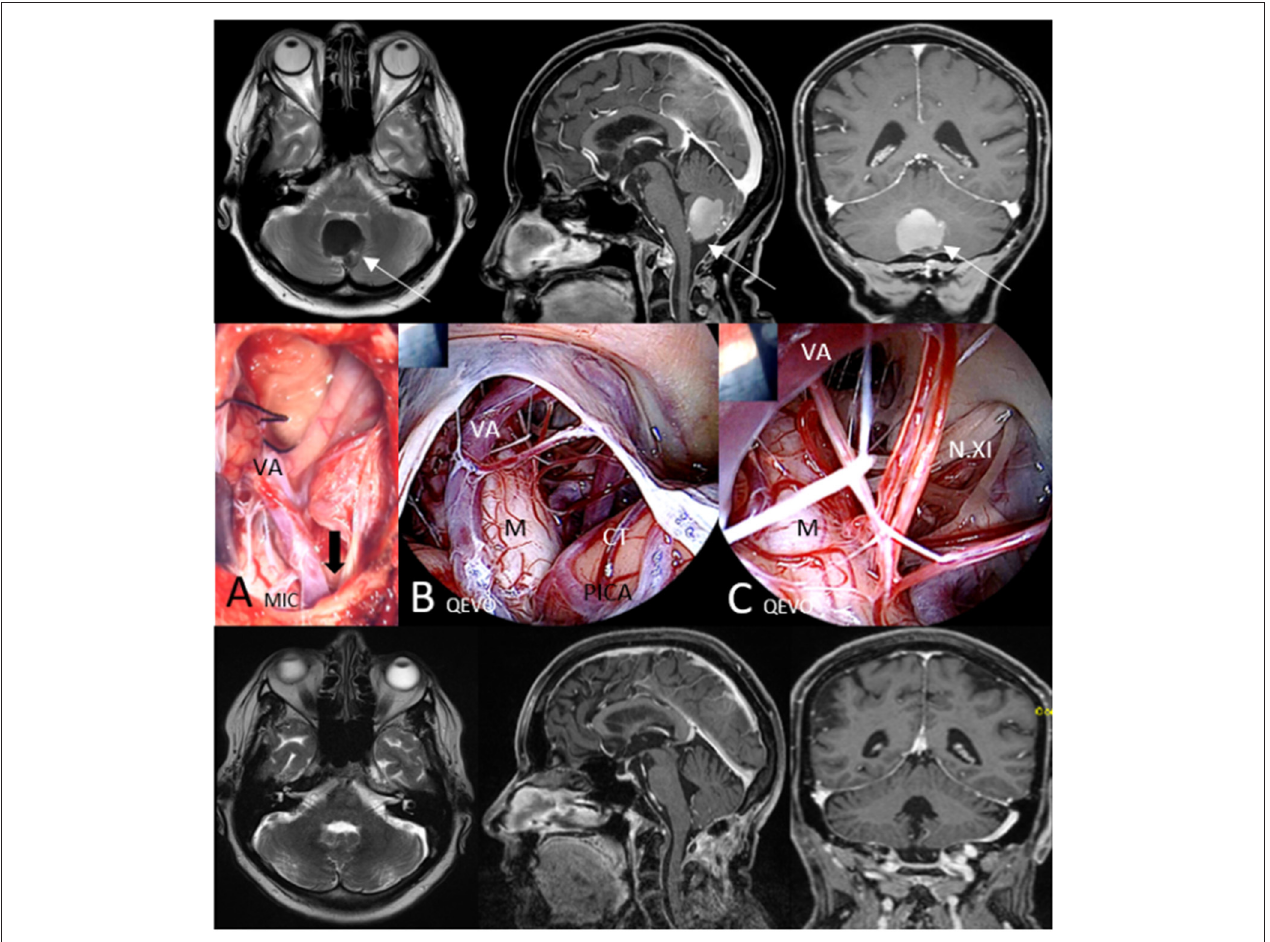
FIGURE 5 | Illustrative case 4—area 4, QEVO ® category E. Patient #9, cerebellar dermoid at the level of the foramen magnum, median suboccipital approach. Upper row, Preoperative MRI in axial plane (T2), sagittal plane, and coronal plane (T1 with contrast medium); (A) MIC(roscopic), View at the resection cavity at the level of the open foramen magnum; the black arrow indicates the visual trajectory of the QEVO® (B, C) ; (B) QEVO, Inspection of the cranio-cervical junction with related structures; C QEVO, Deeper and closer view on the medulla oblongata with lower cranial nerves exiting the spinal canal; Lower row, Postoperative MRI (3 months after surgery) in axial plane (T2), sagittal plane, and coronal plane (T1 with contrast medium). White arrows indicate the tumor in the preoperative MRI, VA means Vertebral Artery, M means Medulla oblongata, CT means Cerebellar Tonsilles, PICA means Posterior Inferior Cerebellar Artery, N.XI, spinal Accessory